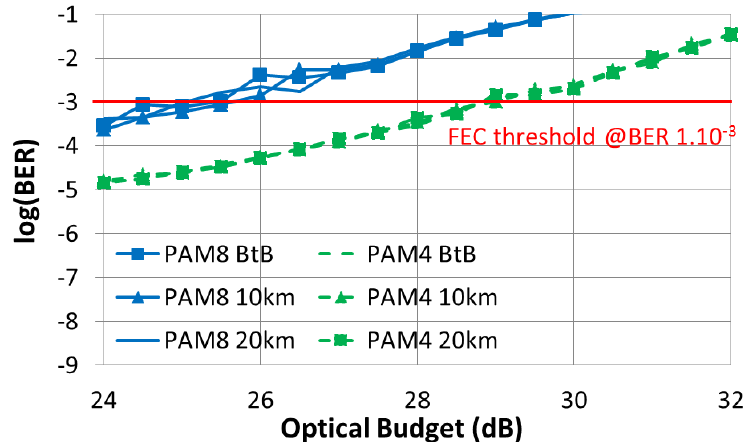
Figure 7. BER of 37.5 Gbit/s PAM8 and 50 Gbit/s PAM4 versus Optical Budgets for 0, 10, and 20 km.